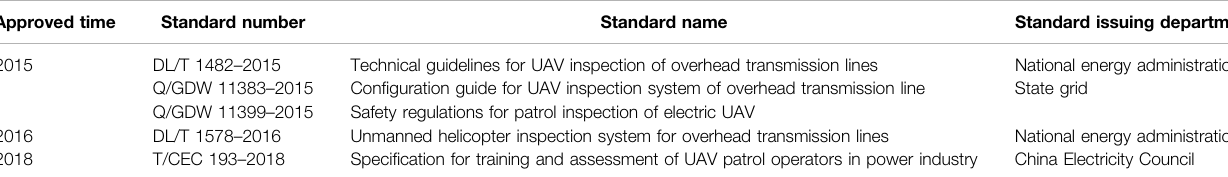
TABLE 3 | Standardization of China ’ s UAV transmission line inspection.